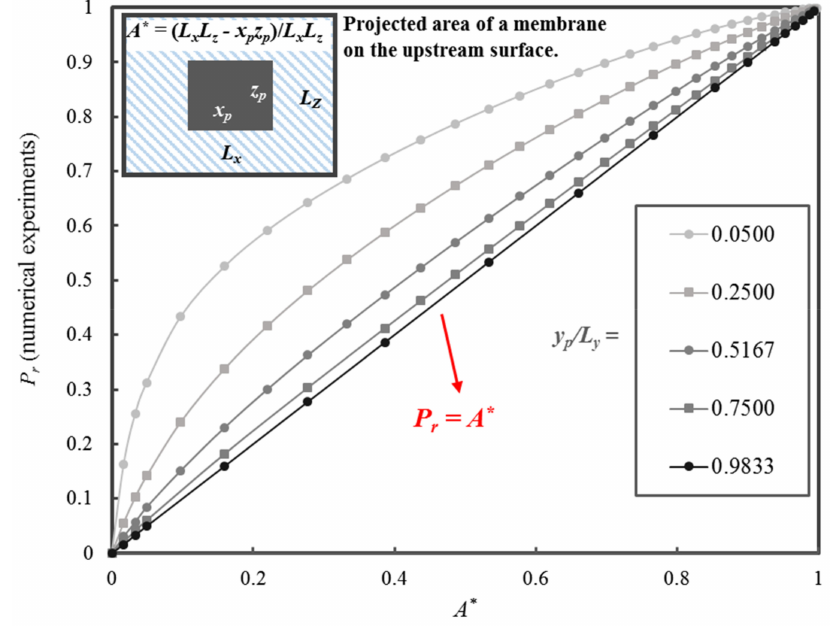
Figure 8. P r of MMMs as a function of A * for five values of y p / L y ranging from 0.0500 to